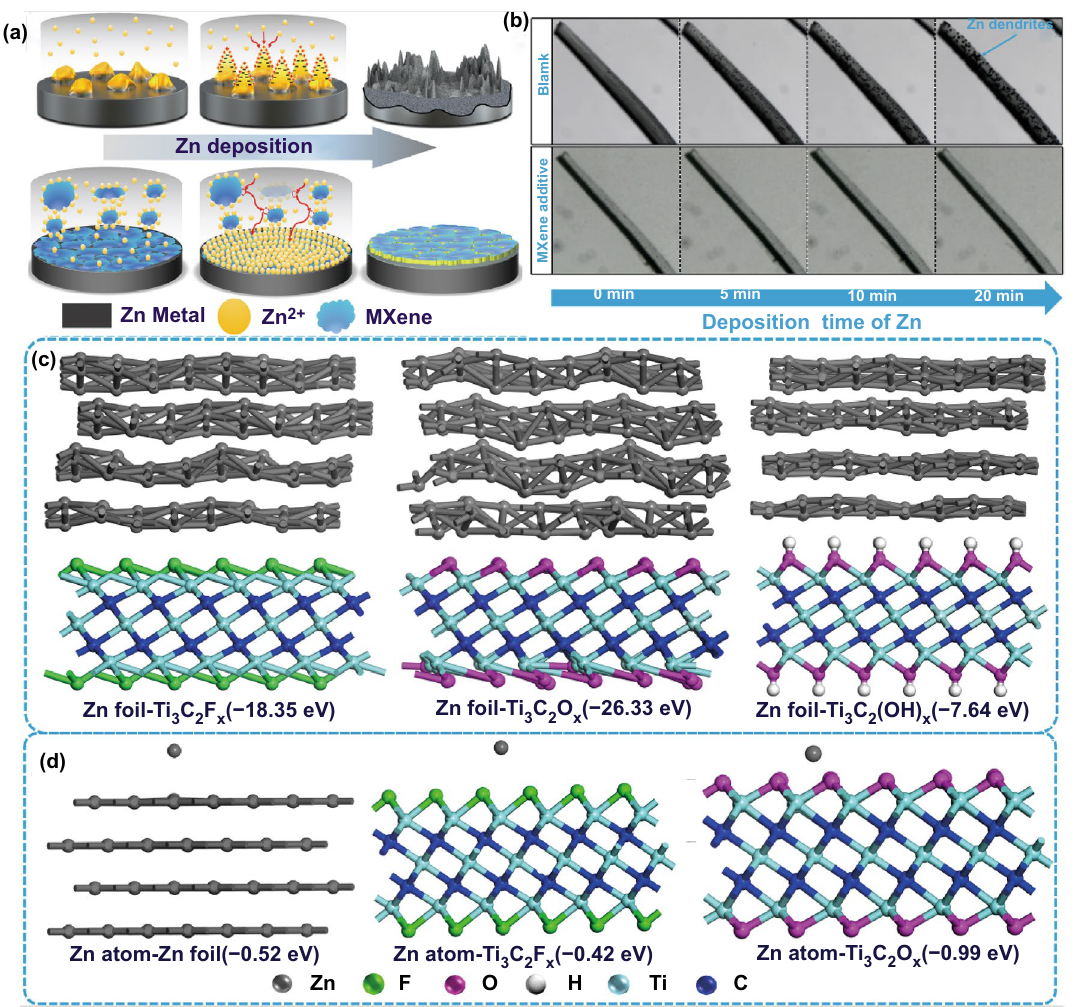
Fig. 1 a Schematic illustration of the effect of MXene additive on the Zn deposition process. b In situ optical microscopy observation of Zn deposition at 4 mA cm −2 in blank ZnSO 4 electrolyte and MXene-added electrolyte. Density functional theory calculation models of c Ti 3 C 2 T x adsorbed on Zn foil and d Zn atoms absorbed on Zn foil, Ti 3 C 2 T x and the corresponding binding